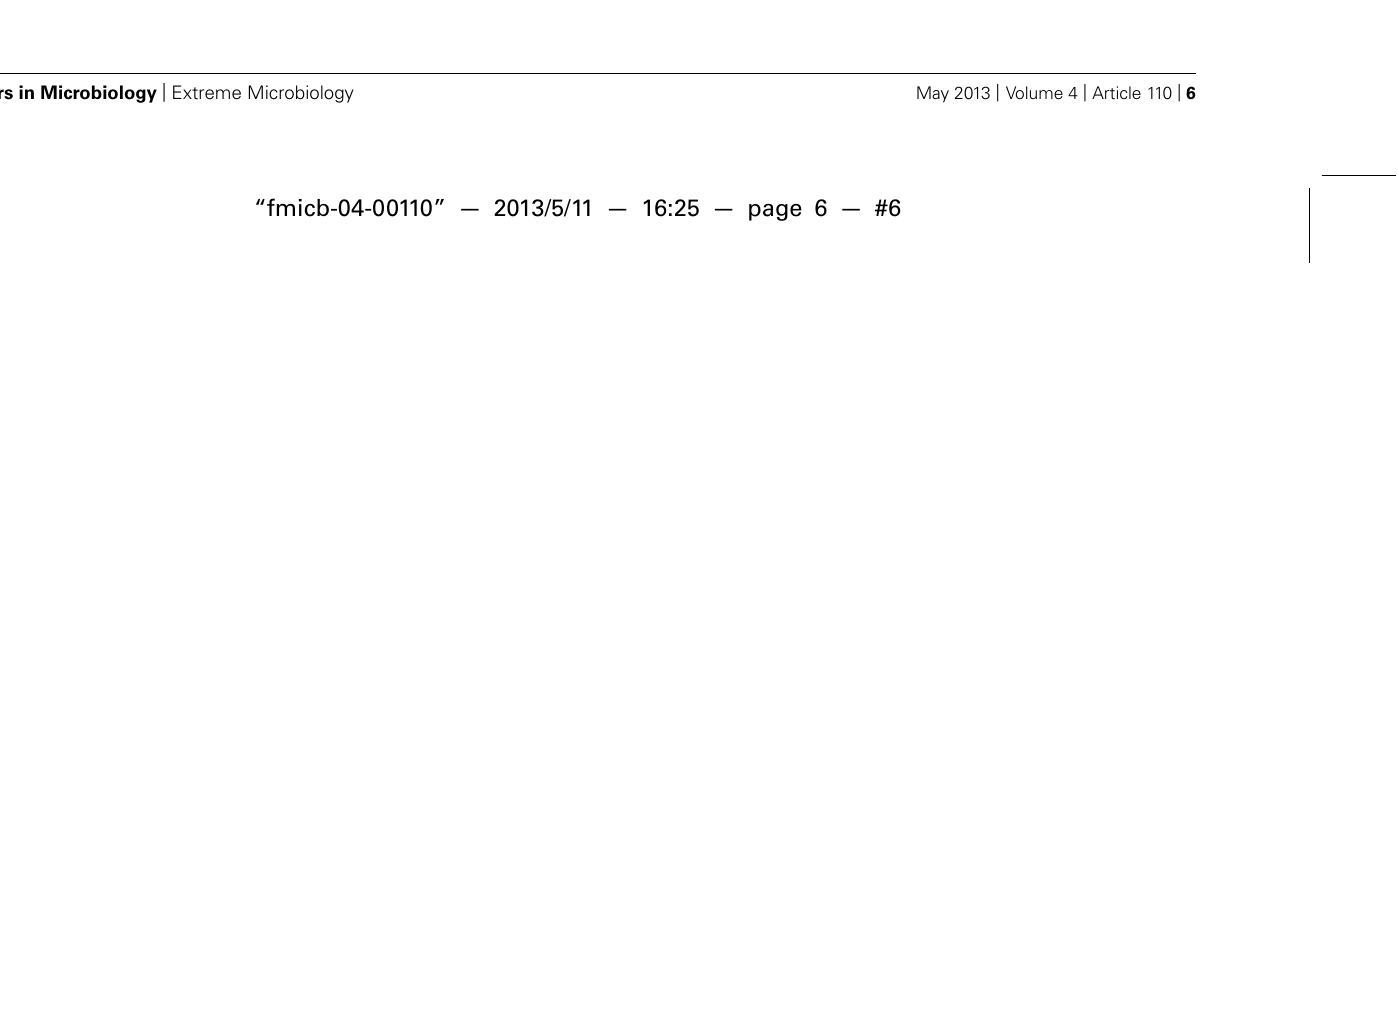
Left and right side panels show the taxonomic breakdown of sequences at the class and order level, respectively. Legend indicates operational taxonomic units (OTUs), defined as sequences sharing 97% nucleotide sequence